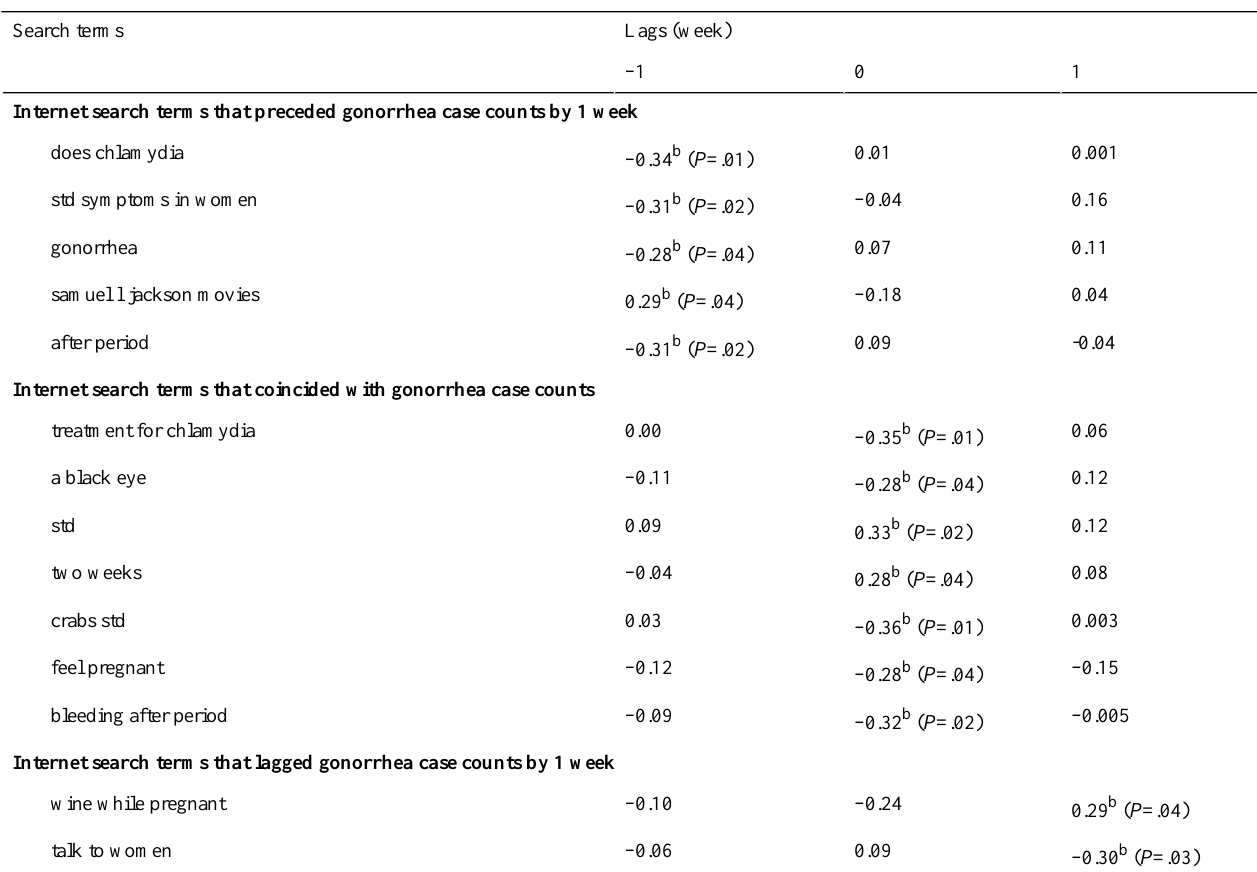
Table 6. Cross-correlation coefficients of reported cases of chlamydia using search term trend data for 2017 a .